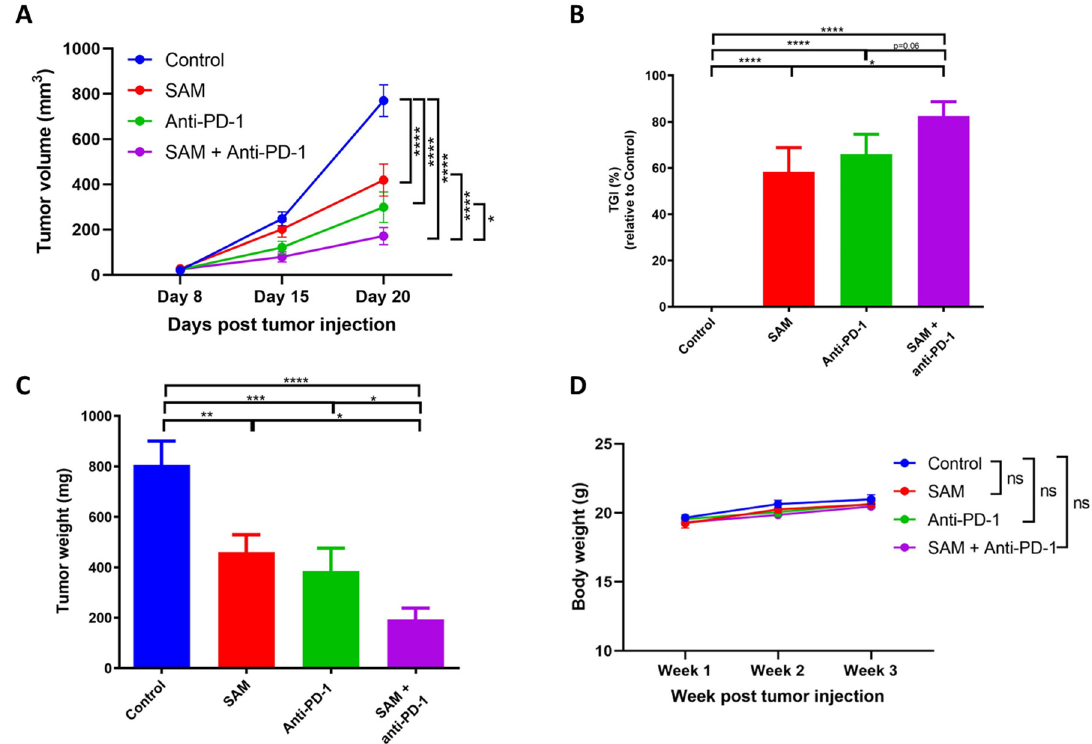
Figure 3. SAM, anti-PD-1 antibody, and the combination treatment decreased primary tumor growth in Eo771 tumor-bearing mice. ( A ) Eo771 (2 × 10 5 cells) were injected at the 4th m.f.p in B6 mice to induce tumor formation. The animals were treated with either the control (isotype matched IgG and PBS), SAM (80 mg/kg/day), anti-PD-1 antibody (5 mg/kg, twice per week), or combination. Tumor volumes were assessed at day 8, 15, and 20, and the animals were sacrificed at day 20.